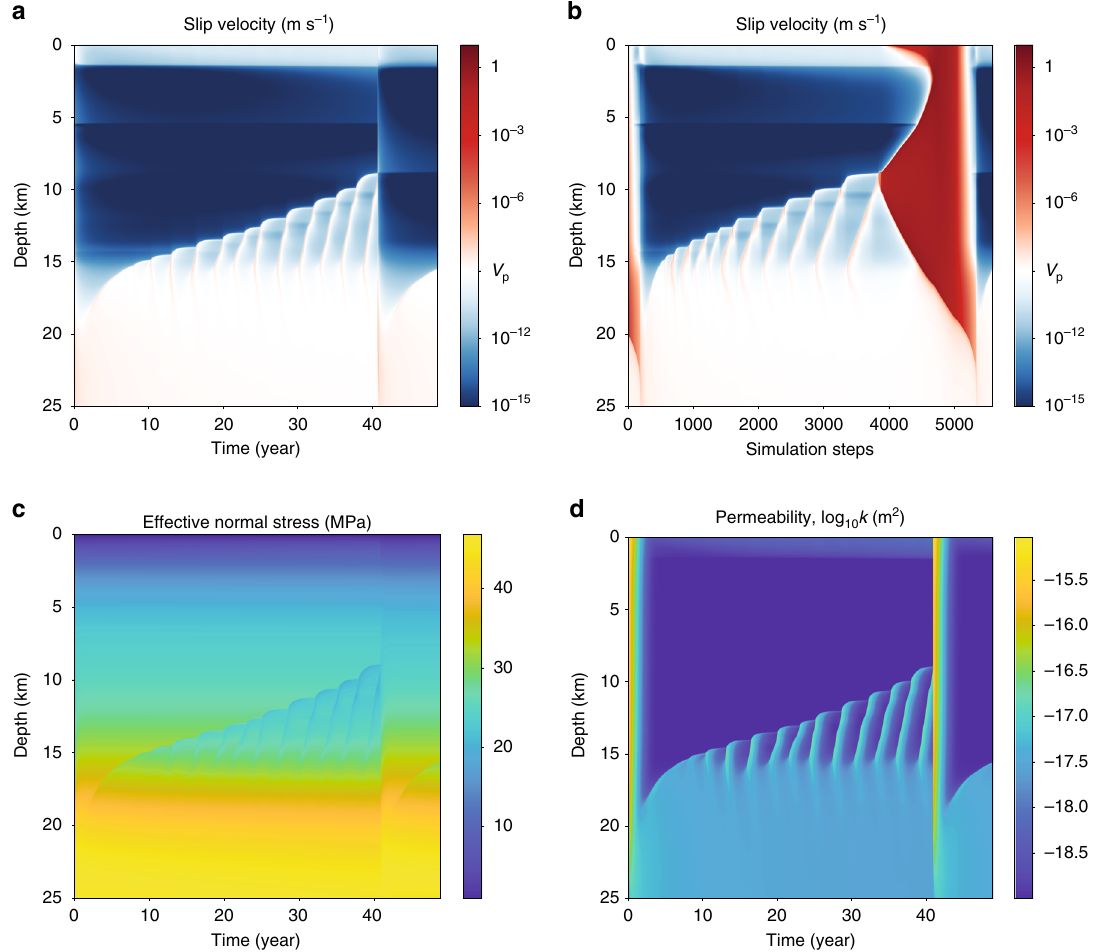
Fig. 5 Quasi-periodic aseismic slip pulses. Evolution of a , b slip velocity; c effective normal stress; and d permeability in the fault valving simulation with T = 0.317 years (and q 0 = 3.3 × 10 − 10 m s − 1 rather than 3 × 10 − 9 m s − 1 , with fl ux chosen to give similar effective stress at depth to T = 3.17 year model). Quasi-periodic fl uid-driven aseismic slip pulses, akin to long-term slow slip events in subduction zones, are spontaneously generated at the base of the seismogenic zone. The reference simulation for this case (not shown) is similar to the reference simulation for T = 3.17 years in Fig. 2a, b and has only periodic, large